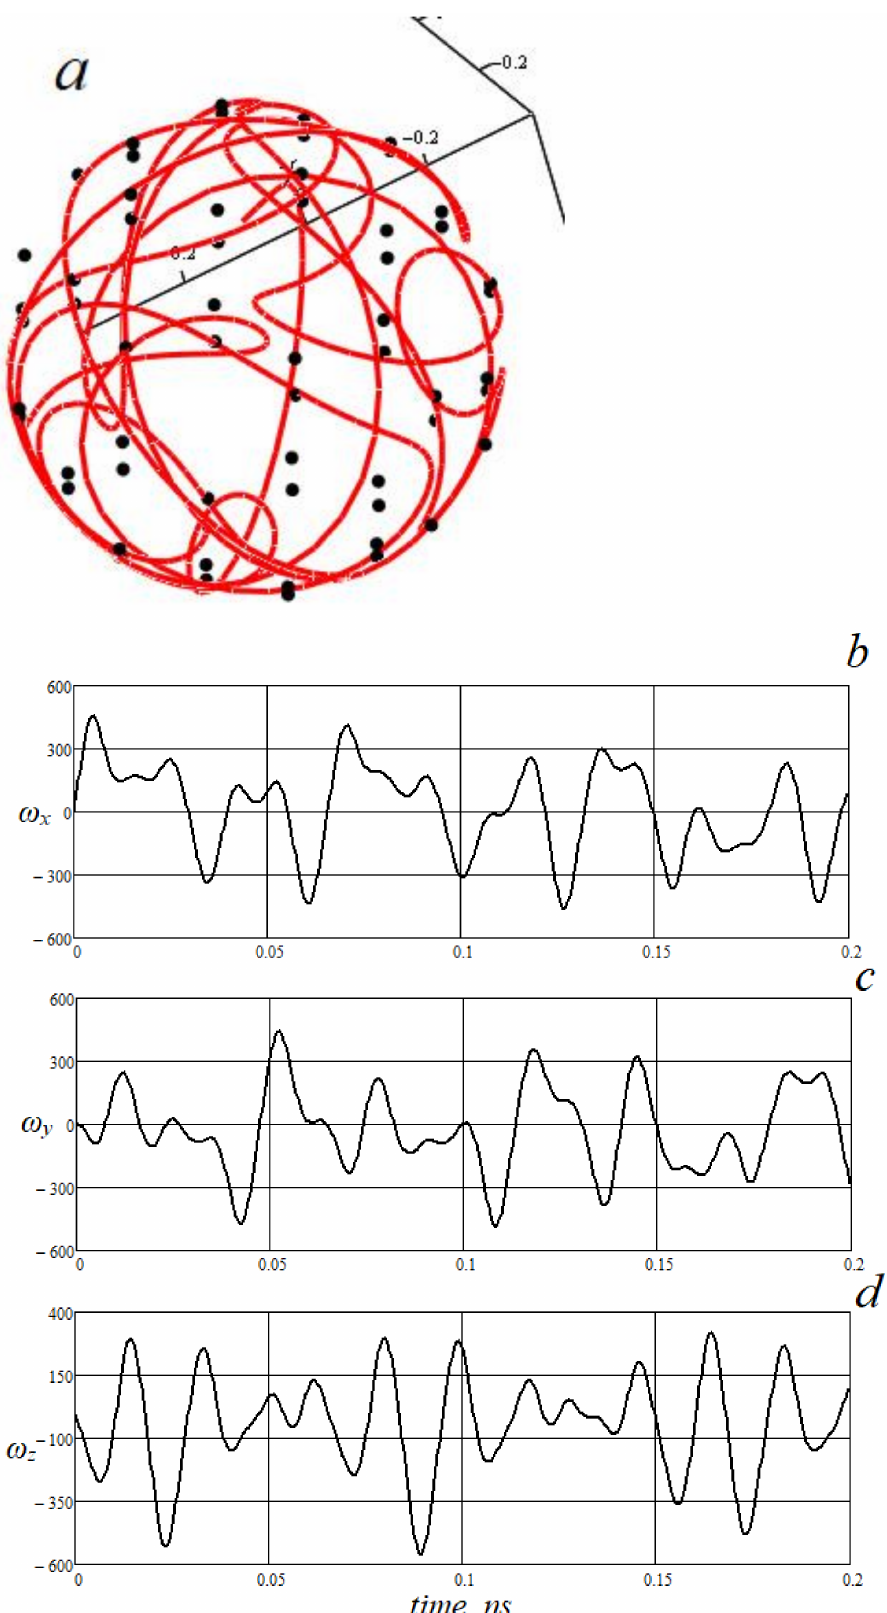
Figure 3. ( a ) Fullerene point trajectory; ( b ) x -projection of fullerene rotation frequency; ( c ) y -projection of fullerene rotation frequency; ( d ) z -projection of fullerene rotation